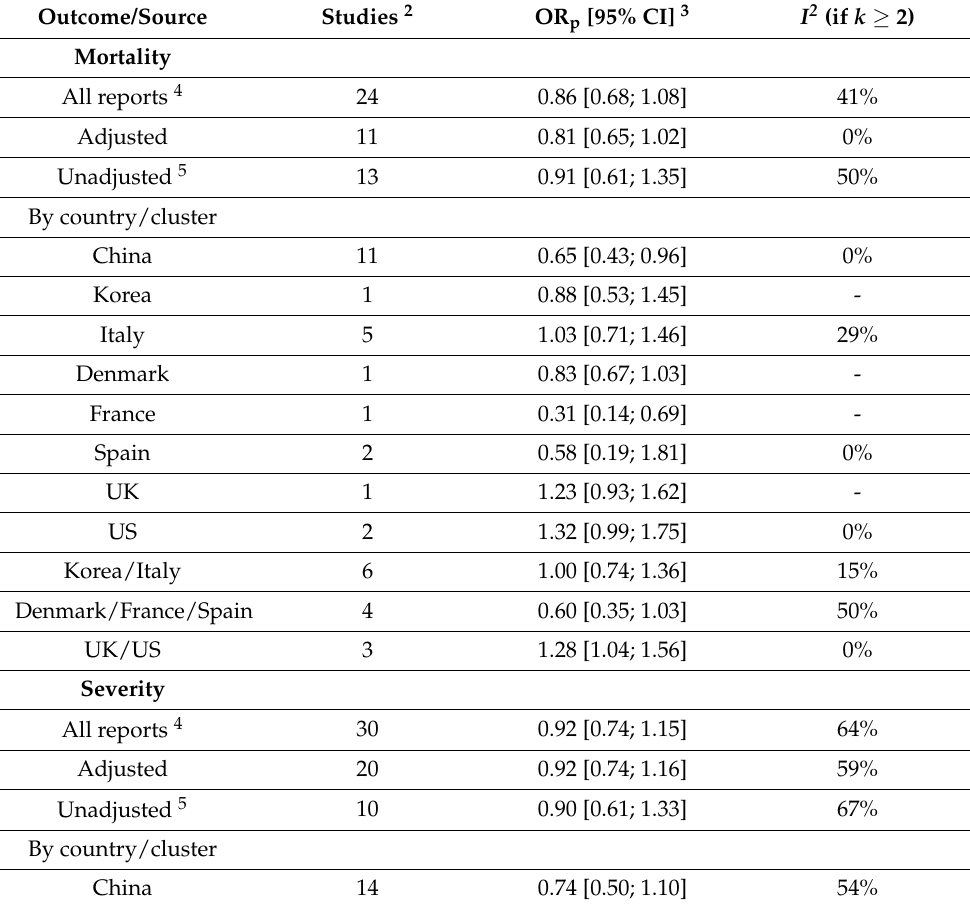
Table 1. Overall and stratified pooled risk estimates for mortality, severity, and hospitalization 1 . Outcome/Source Studies